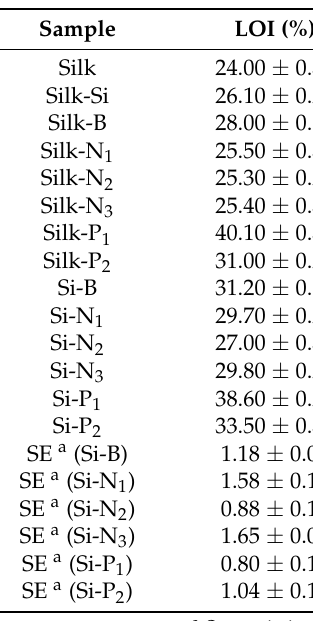
Table 2. LOI and the vertical burning results for all